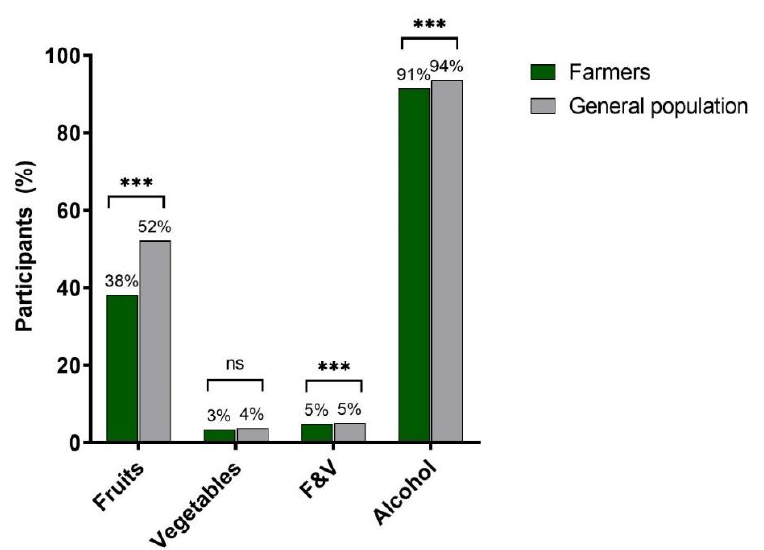
Figure 2. Participants’ percentage of recommendations’ fulfillment for fruit, vegetables, and alcohol.